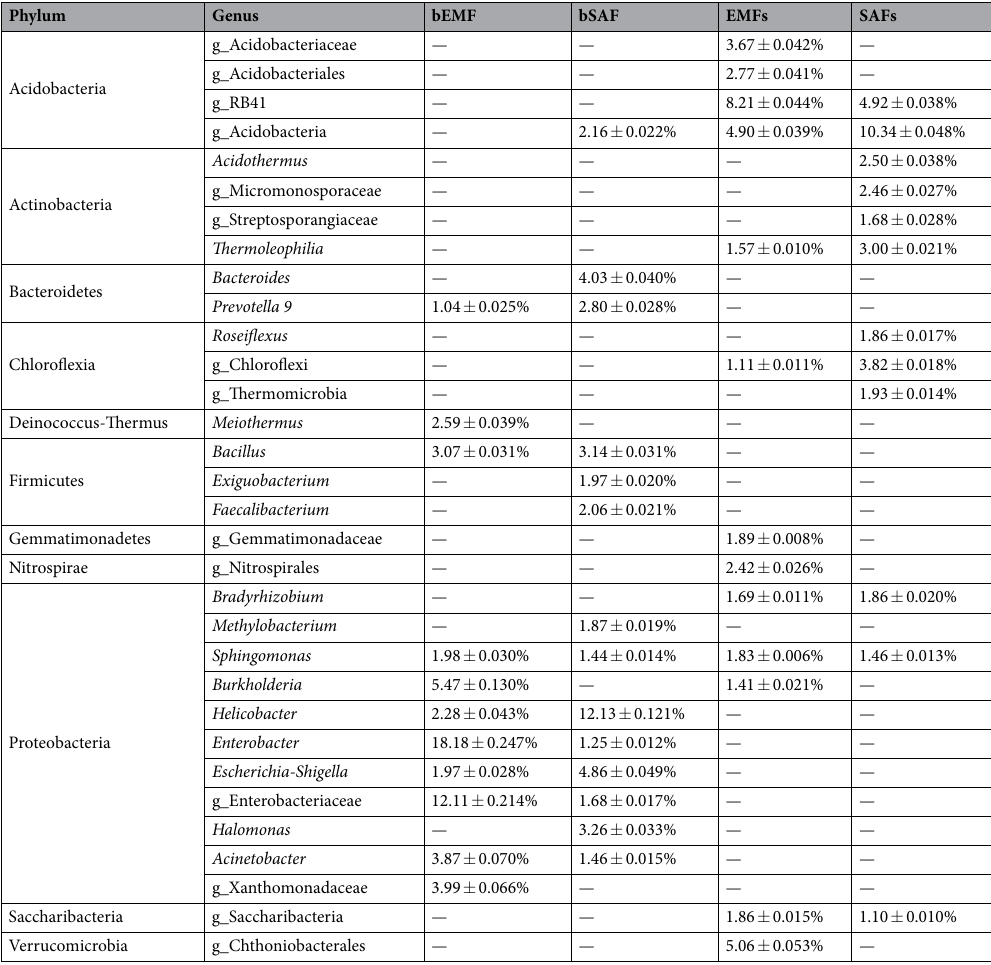
Table 2. Distribution of dominant bacteria from different sample groups based on the classification level of genus. “—”, the genus with relative abundance of less than 1%. bEMF, the endophytic bacteria within the fruit bodies of EcMF; bSAF, the endophytic bacteria within the fruit bodies of SAF; EMFs, the bacteria of hyphosphere soils below the fruit bodies of EcMF; SAFs, the bacteria of hyphosphere soils below the fruit bodies of